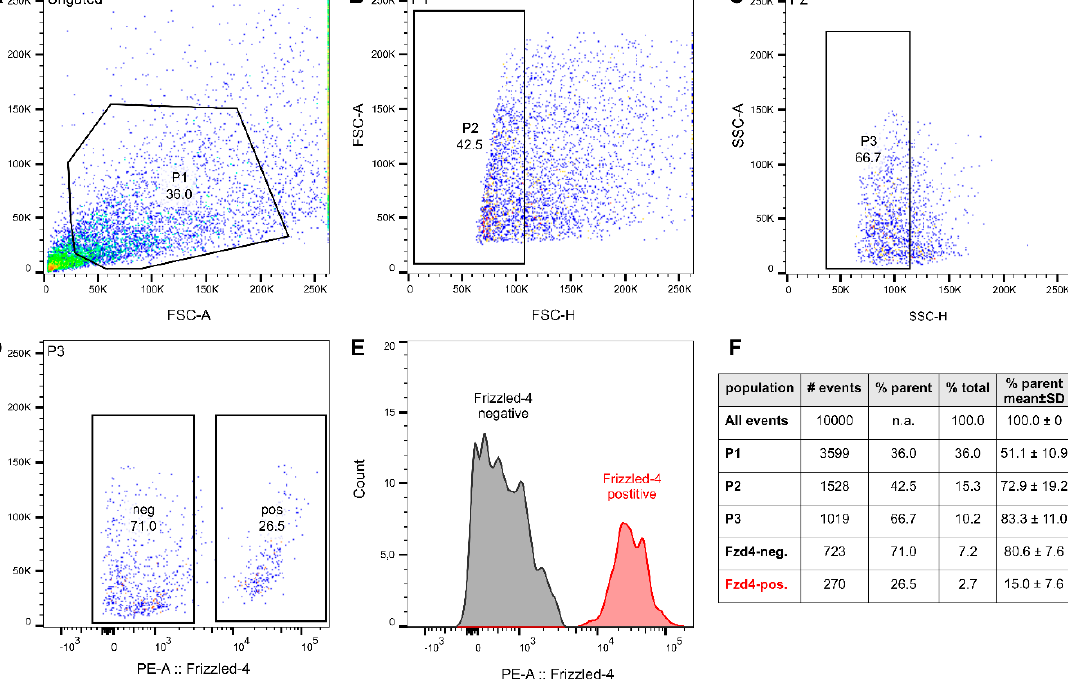
Figure 2. Fluorescence-activated cell sorting (FACS) sorting of Fzd4 marked cells derived from human Tunica muscularis . Shown is the scatter blot with sequential gates (Ungated, P1–P3; A – C ) as well as